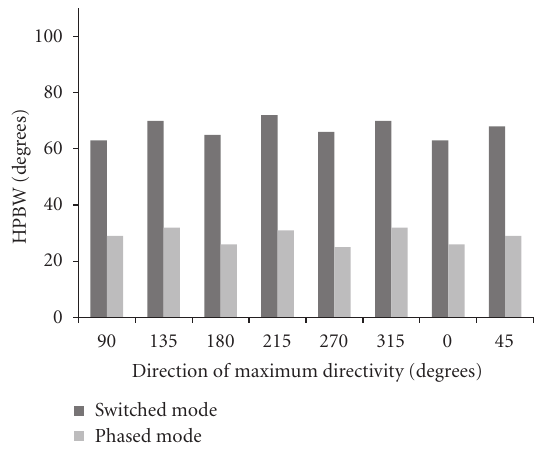
Figure 9: HPBW simulation comparison for the Yagi array placed 5cm over the ground plane.